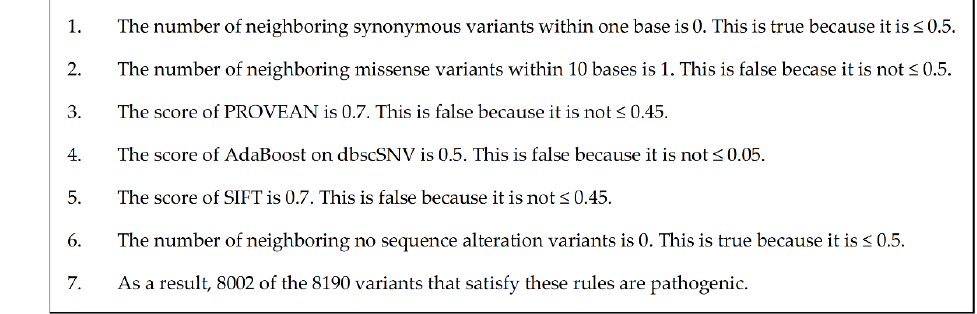
Figure 6. This is the decision trees model for the variant MYO7A NM_000260.4(MYO7A):c.5618G>A (p.Arg1873Gln) visualized using PyDotPlus (version 2.0.2). The paths circled in red are the subtrees that illustrate the case study. The red box was described manually. Several important nodes were enlarged for ease of viewing. This figure is an enlarged version of the red box area overall.